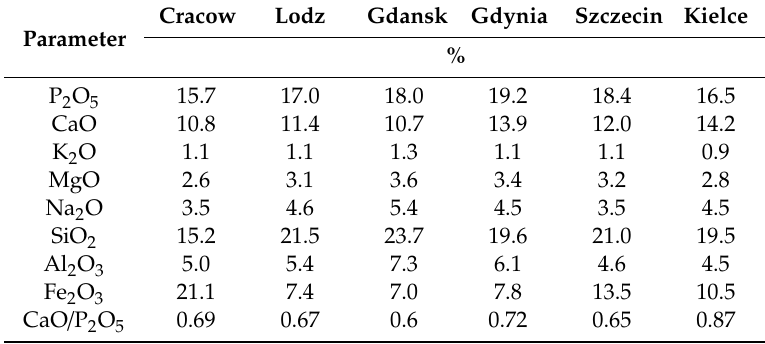
Table 4. Mass fractions of main elements (expressed as oxides) of the thermochemically treated SSA. Cracow Parameter